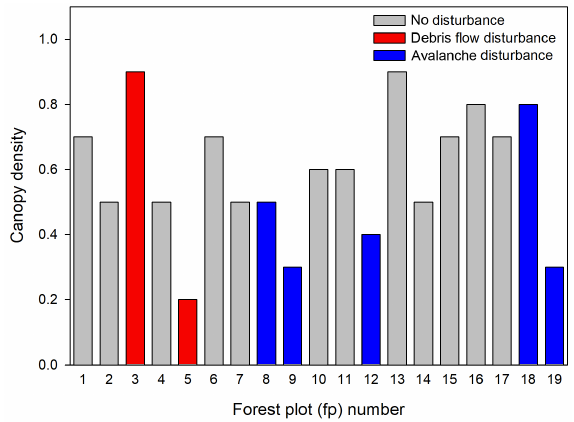
Figure 4. Canopy density distribution (%) per plot.